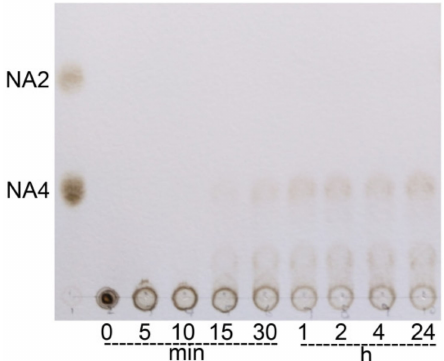
Figure 5. Thin layer chromatography analysis of Ca Aga1-catalyzed hydrolysates of agarose. NAOS standards—NA2 (neoagarobiose) and NA4